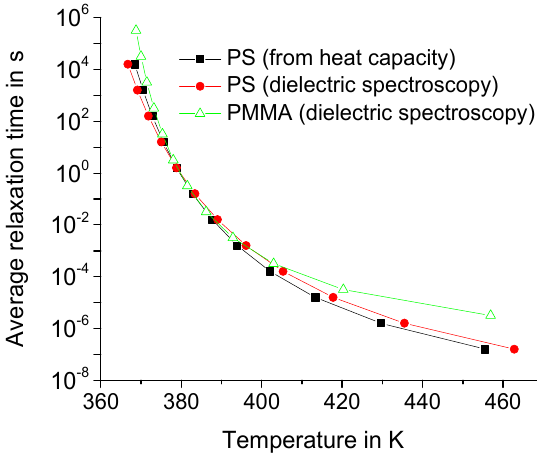
Figure 5. Temperature dependence of the average relaxation time (cid:101) τ AV ( T ) for polystyrene (PS) and poly(methyl methacrylate) (PMMA), the filled and open symbols, respectively.